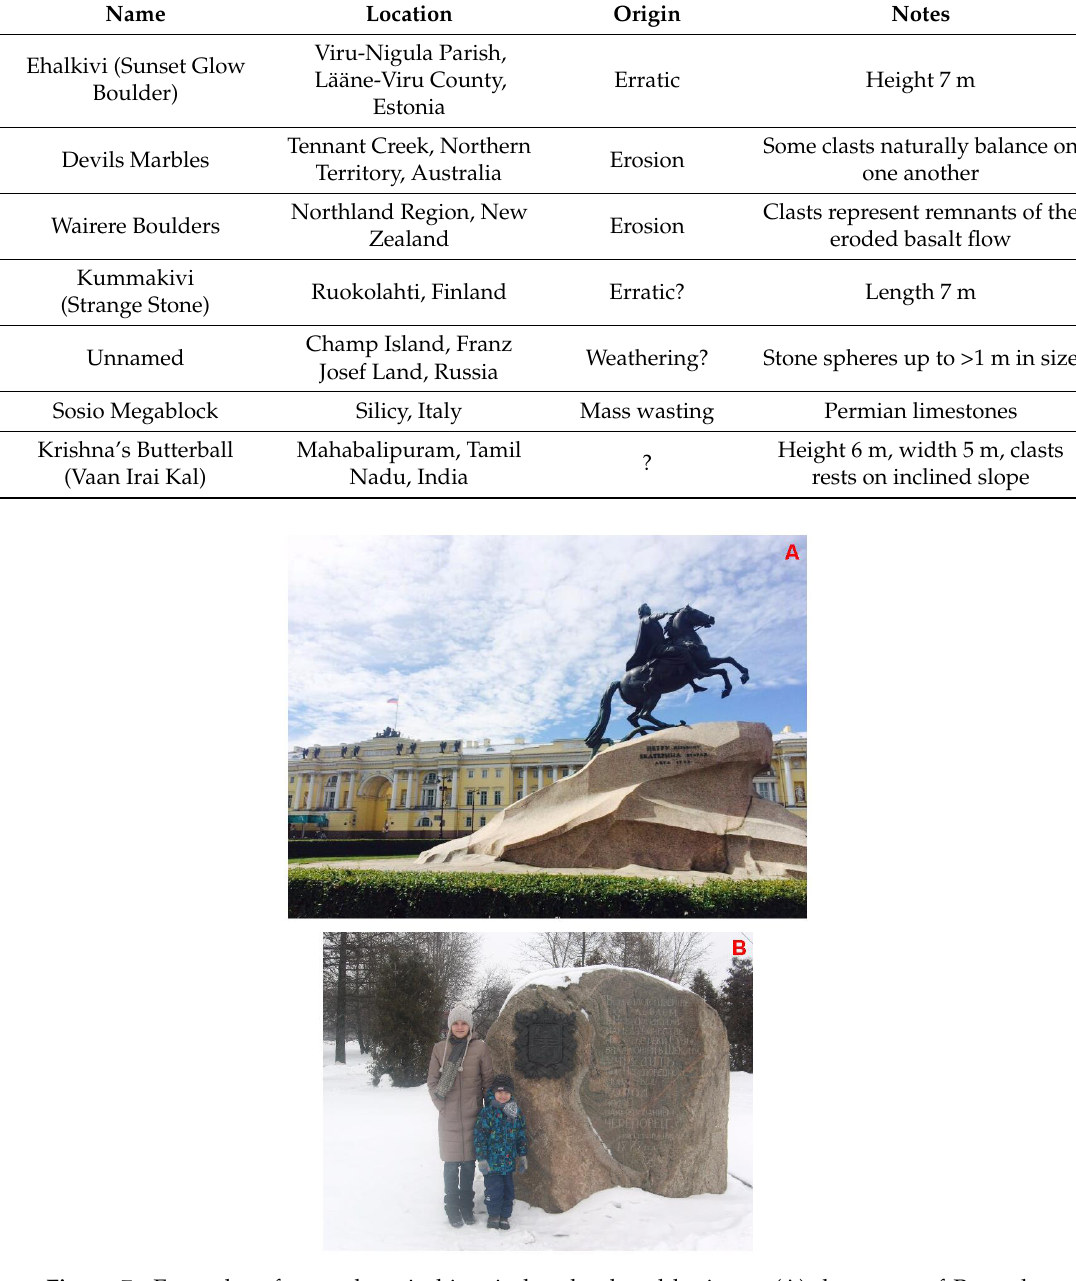
Figure 7. Examples of megaclasts in historical and cultural heritage: ( A ) the statue of Peter the